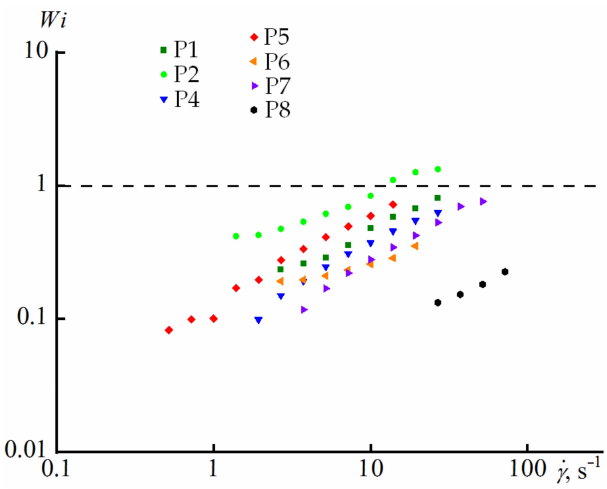
Figure 5. Frequency dependences of the loss tangent at 130 ( a ) and 190 ◦ C ( b ). The polymer numbers are presented in the legends.